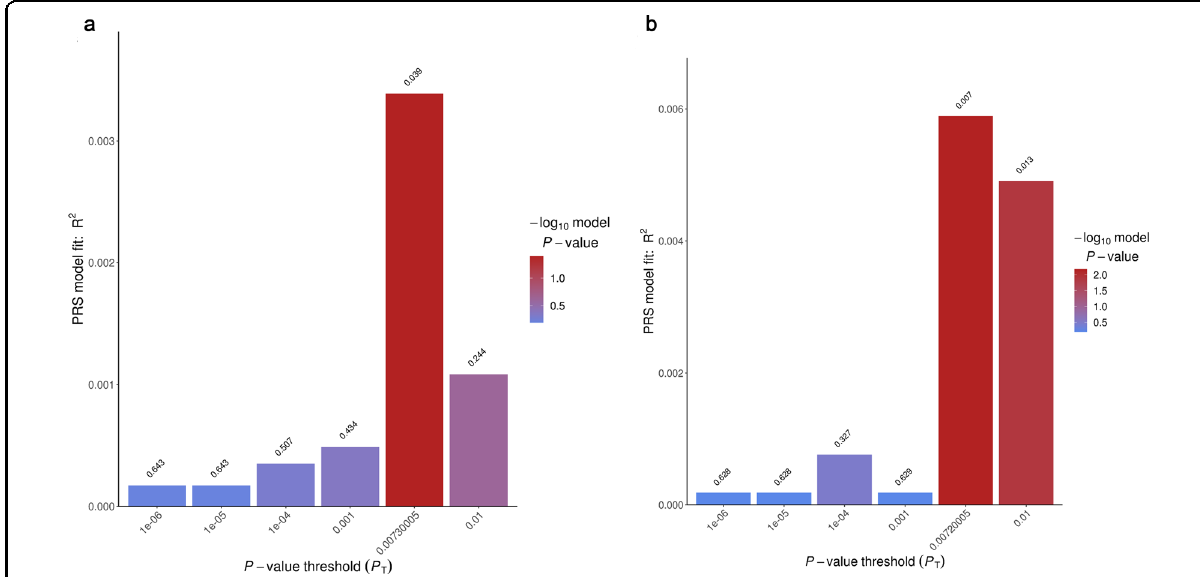
Fig. 2 Ploygenic risk score pro fi ling using the European results as the discovery set and the Chinese data as the testing set. The x axis shows six P value thresholds ( P = 1e-6, 1e-5, 1e-4, 1e-3, and 1e-2) and the best-threshold ( P = 7e-3), which showed the maximal Nagelkerke R2 . The y axis shows the Nagelkerke R2 , i.e., the proportion of variance in case-control status explained by the risk score pro fi le. The number above each bar is the P value for the capacity of the risk score pro fi le to predict case-control status for that PT. a The GWAS results of males as the discovery set. b The GWAS conducted in males and females combined as the discovery